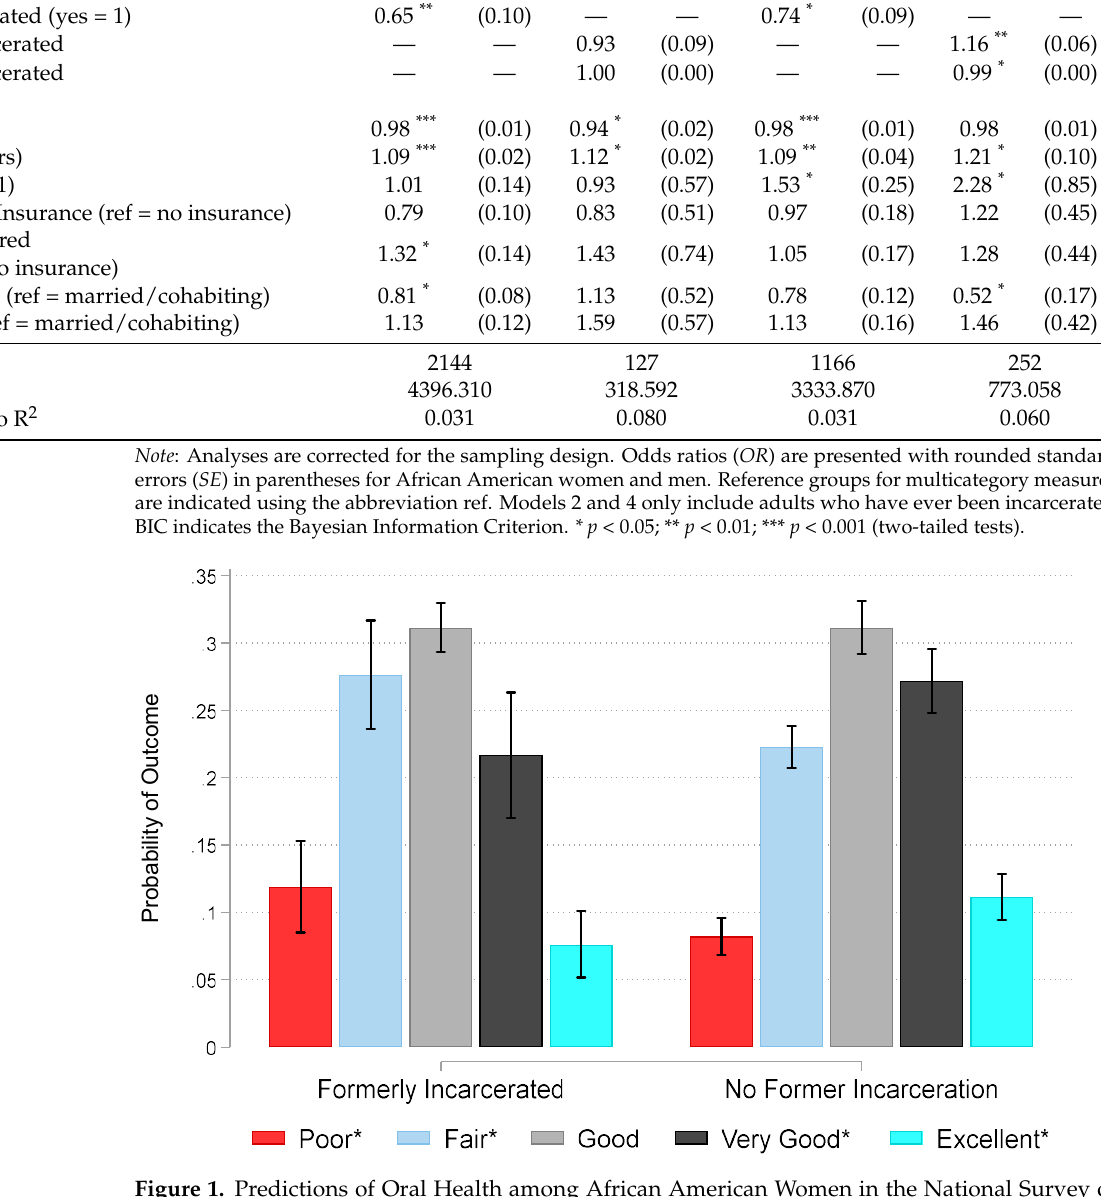
Figure 2. Predictions of Oral Health among African American Men in the National Survey of Amer- ican Life, 2003. Note : Fully-adjusted estimates generated from Model 3 in Table 2 (n=1,166). Proba- bilities of poor, fair, and good health are significantly higher for formerly incarcerated men. Proba- bilities of very good and excellent health are significantly lower for formerly incarcerated men. * Probabilities of an outcome are significantly different for formerly and never incarcerated men at p < 0.05.